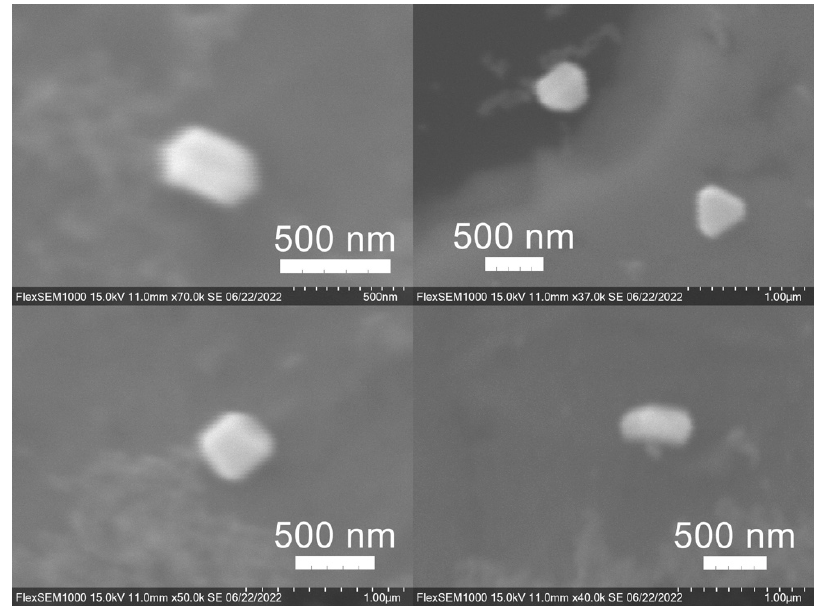
Figure 12. Silver (Ag) nanoparticles synthesized using spent coffee grounds of medium roast used in cold brew coffee (SME).